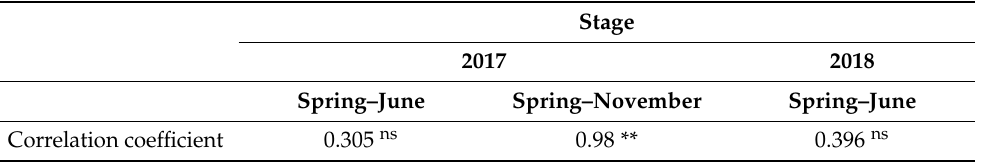
Table 4. Spearman’s correlation coefficient relating fertilizer nitrogen uptake in the current year to the dry mass weight of each organ during different